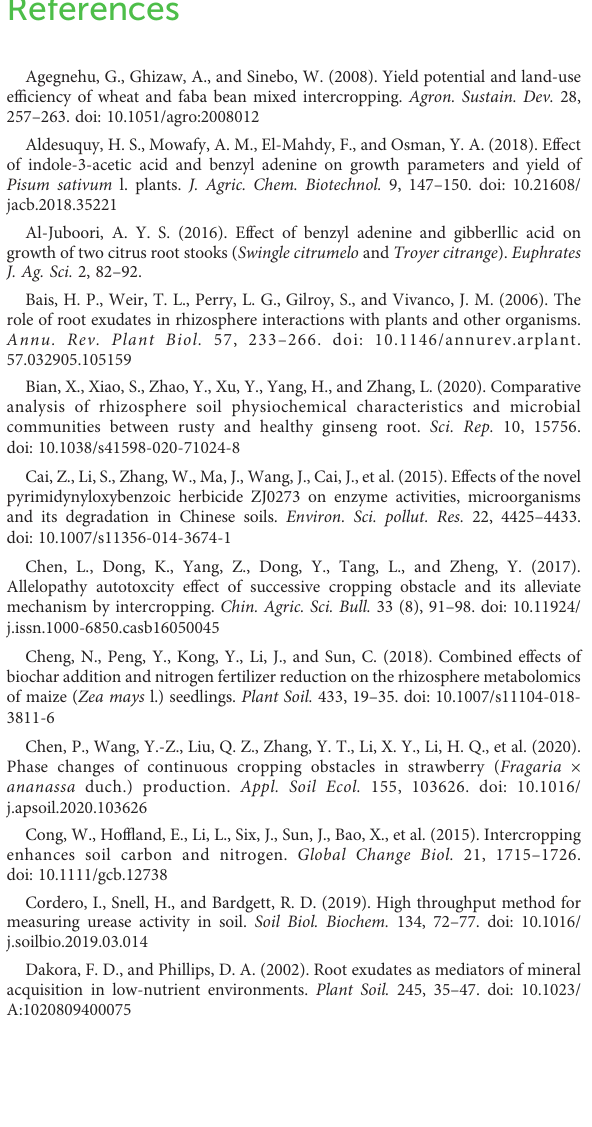
SUPPLEMENTARY TABLE 2 Differentially signi fi cant metabolites among different root treatments and different rhizosphere soil